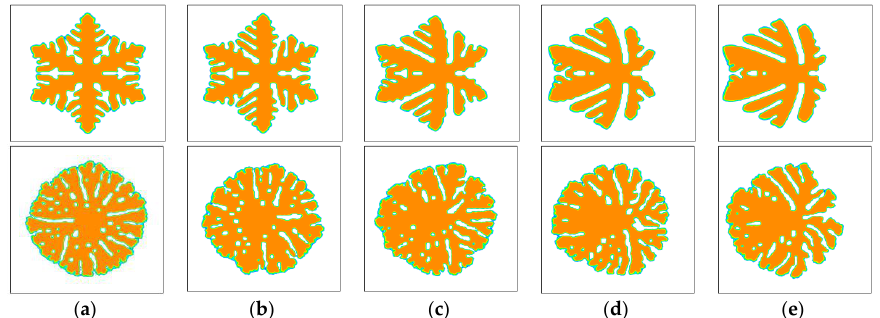
Figure 4. Simulated morphology of snowflake and seaweed crystals at t = 600. The inlet velocity is changed from u 0 = 0 to u 0 = 1.0 and the viscoelastic parameter is set as We = 1.0. The snowflake crystals and seaweed crystals are arranged in the top row and bottom row, respectively. In simulations, the snowflake morphology is triggered by the anisotropy with the number of mode j = 6 and the seaweed morphology is triggered by a uniformly distributed noise added on the growing interface with the amplitude A = 0.1 [50]. ( a ) u 0 = 0; ( b ) u 0 = 0.2; ( c ) u 0 = 0.5; ( d ) u 0 = 0.8; ( e ) u 0 =